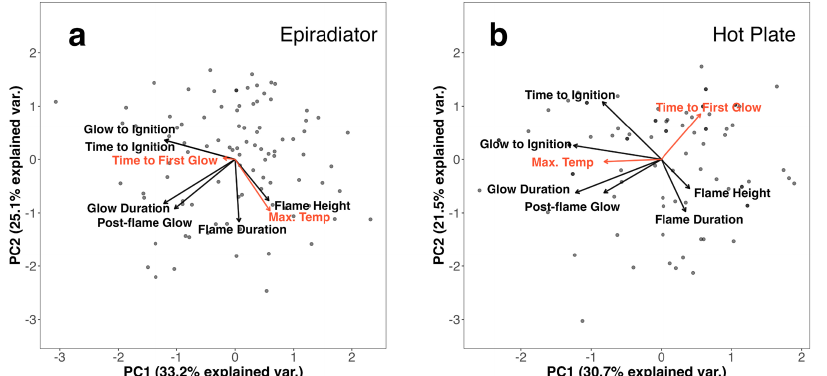
Figure 4. Principal component analyses for all measured flammability metrics for both the ( a ) epiradiator and ( b ) hot plate methods. Key differences between the two methods are highlighted with red-orange arrows and text labels. Table 2. PCA loadings following varimax rotation for the two principal component analyses shown in Figure 4. Bolded values represent instances where flammability metrics have loadings with